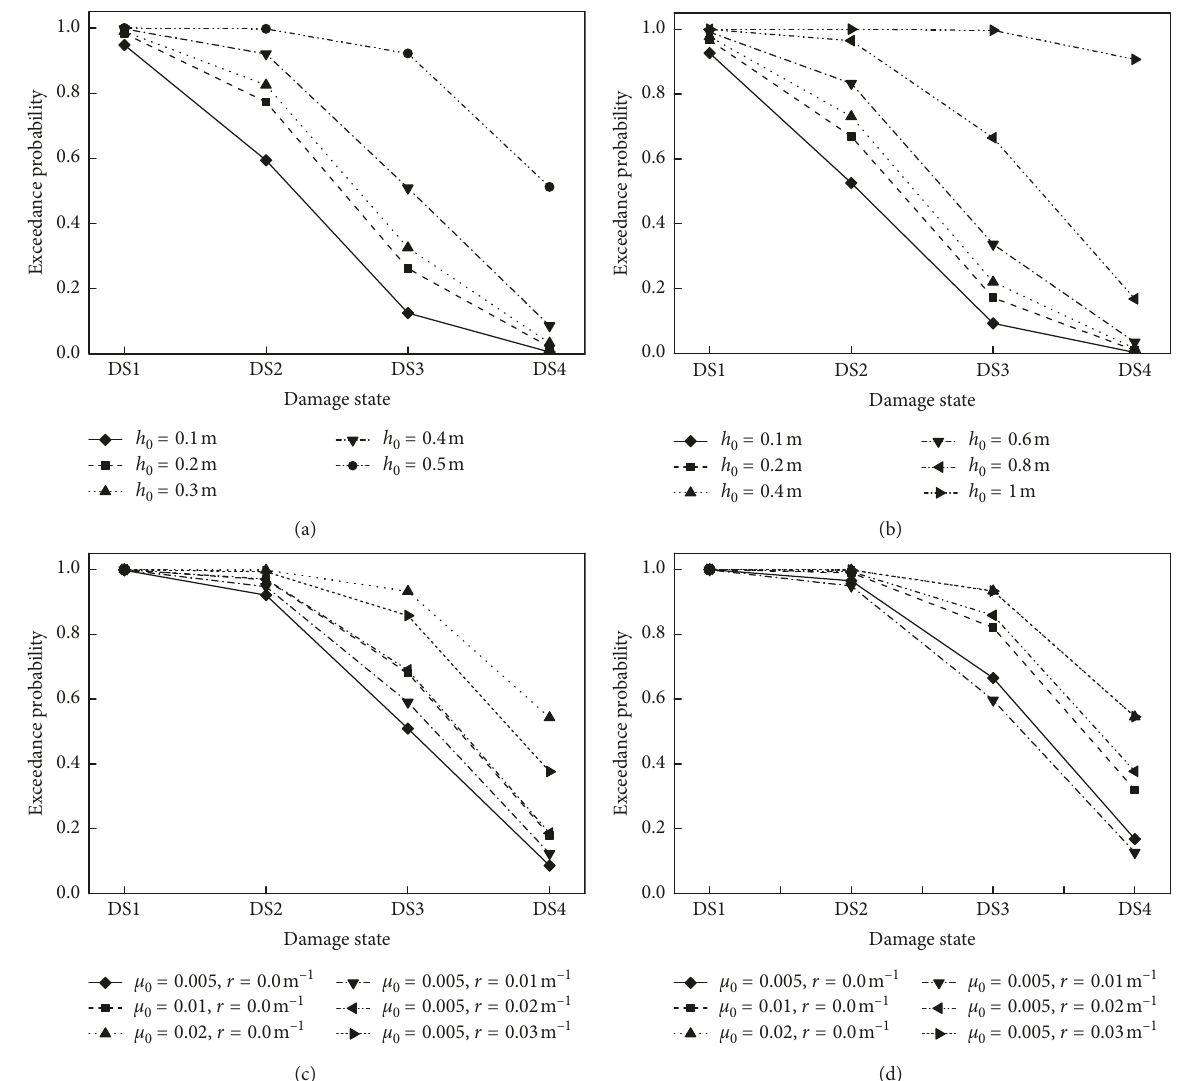
Figure 6: Structural residual displacement when K DS4 are defined by the structural residual displacement in Table 2). (a) μ 0 h . 0m. (c) h . 5m, h . 4m. (d) h 1 (cid:31) 1 1 (cid:31) 0 0 (cid:31) 0